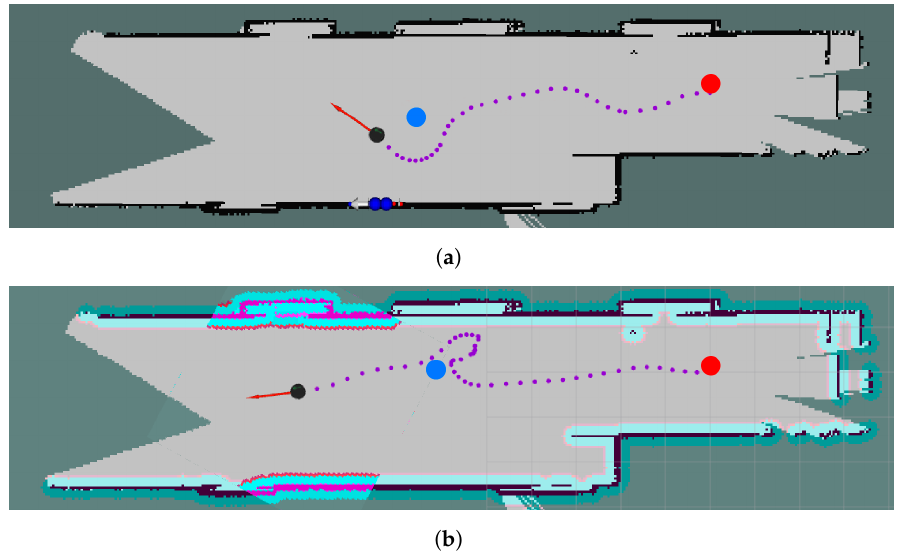
Figure 15. Social navigation examples for the reactive method Sarl* in a corridor scenario. Robot position in black; person position in blue; starting robot position in red; and robot path in purple. In the first situation ( a ) the person was static, while in the second one ( b ) he was walking slowly towards the robot position. In this second case, the robot came closer to the person without respecting the intimate space (Proxemics